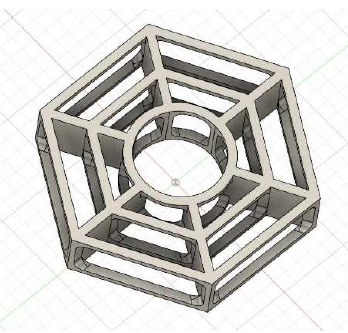
Figure 6. Snowflake inspired unit cell (8 × 8 × 2 mm).